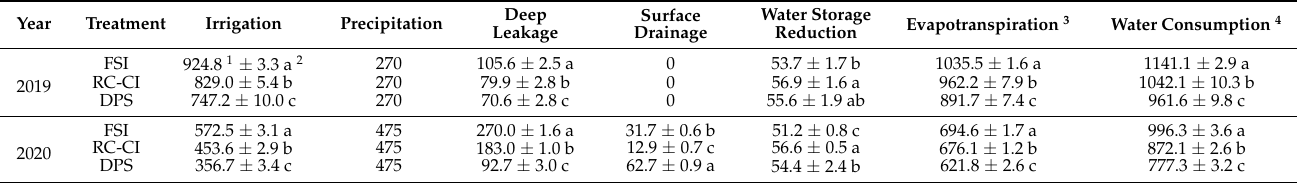
Table 3. Water consumption of rice in whole growth period under different irrigation and drainage modes.